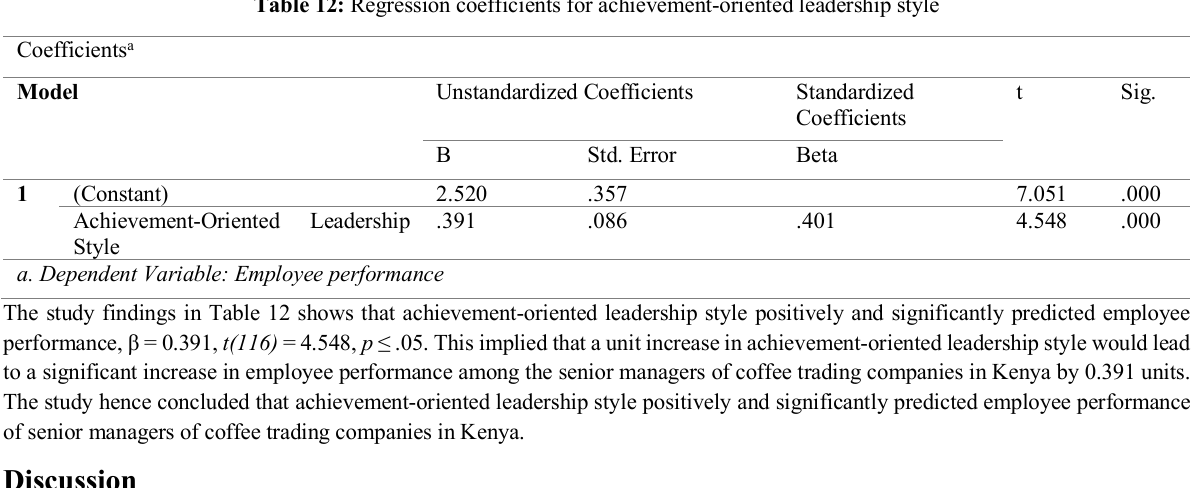
Table 12: Regression coefficients for achievement-oriented leadership